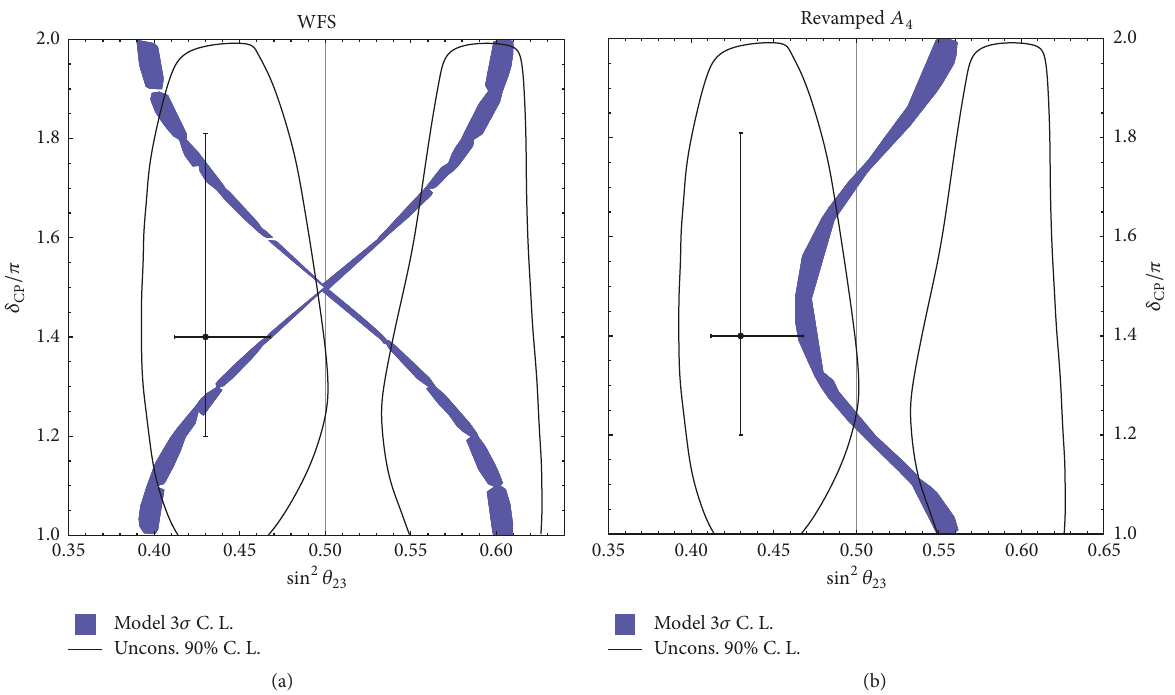
Figure 3: In blue arepossible parametervalues allowed by thetwo benchmarkmodels: WarpedFlavorSymmetry (a)and Revamped 𝐴 4 -BMV (b). The regions are constructed by varying all the free parameters of the model and selecting those that are allowed at 3𝜎 in current global fit analysis [82]. The black line corresponds to current 90% CL region and the black-dot is the best fit of Table 3. Normal Hierarchy is assumed.